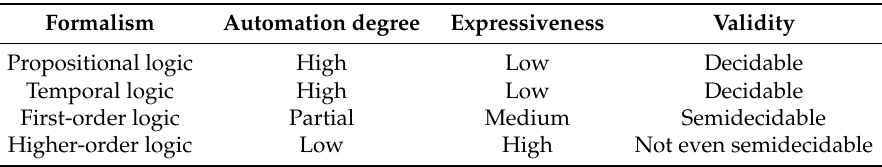
Table 1. Characteristics from different formalisms for Automated Theorem